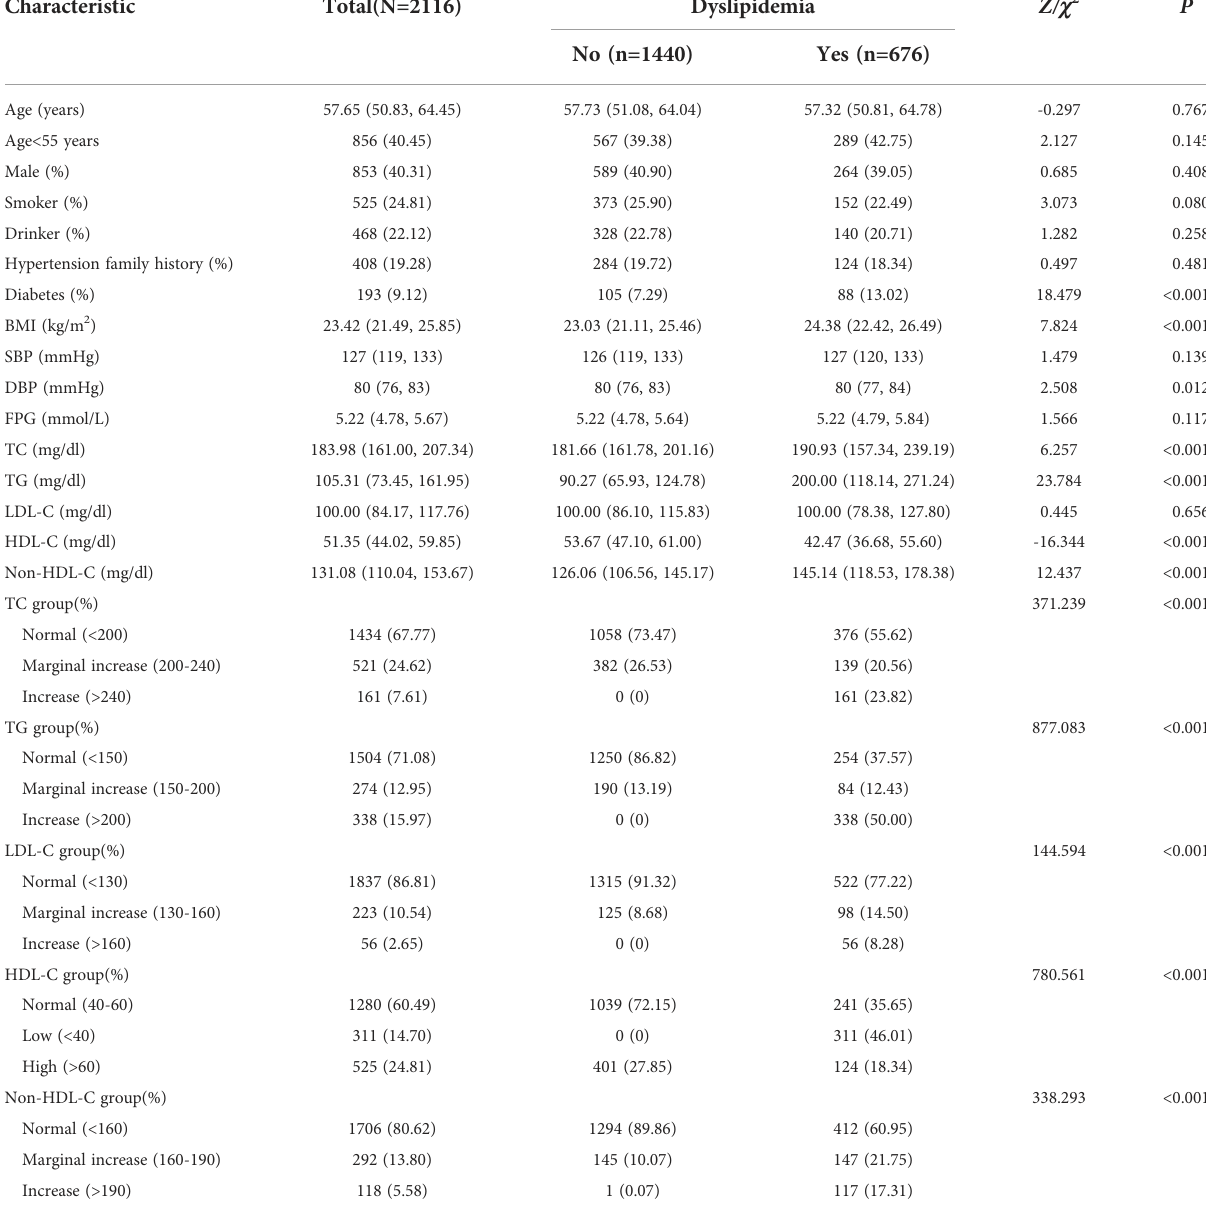
TABLE 1 Baseline characteristics of the study population by dyslipidemia status.